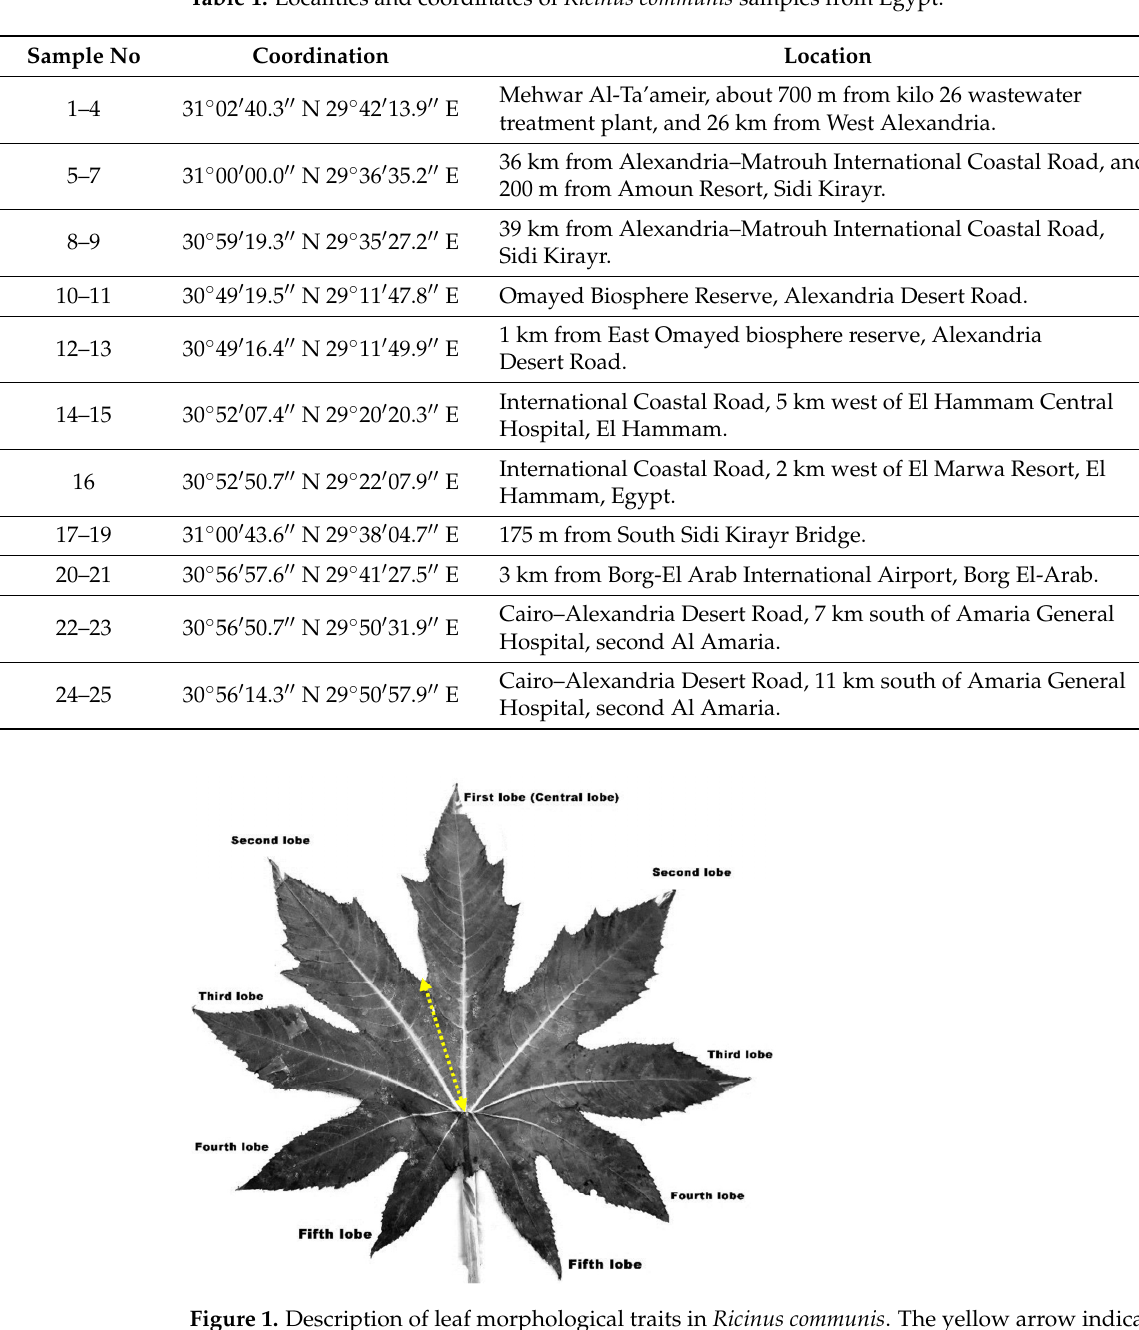
Table 1. Localities and coordinates of Ricinus communis samples from Egypt.